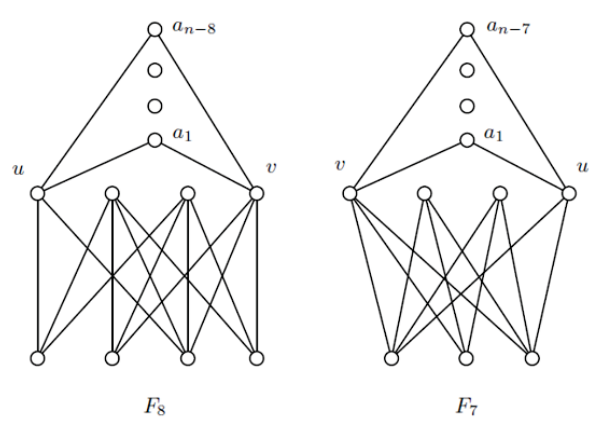
Figure 3: Graphs constructed in the proof of Claim